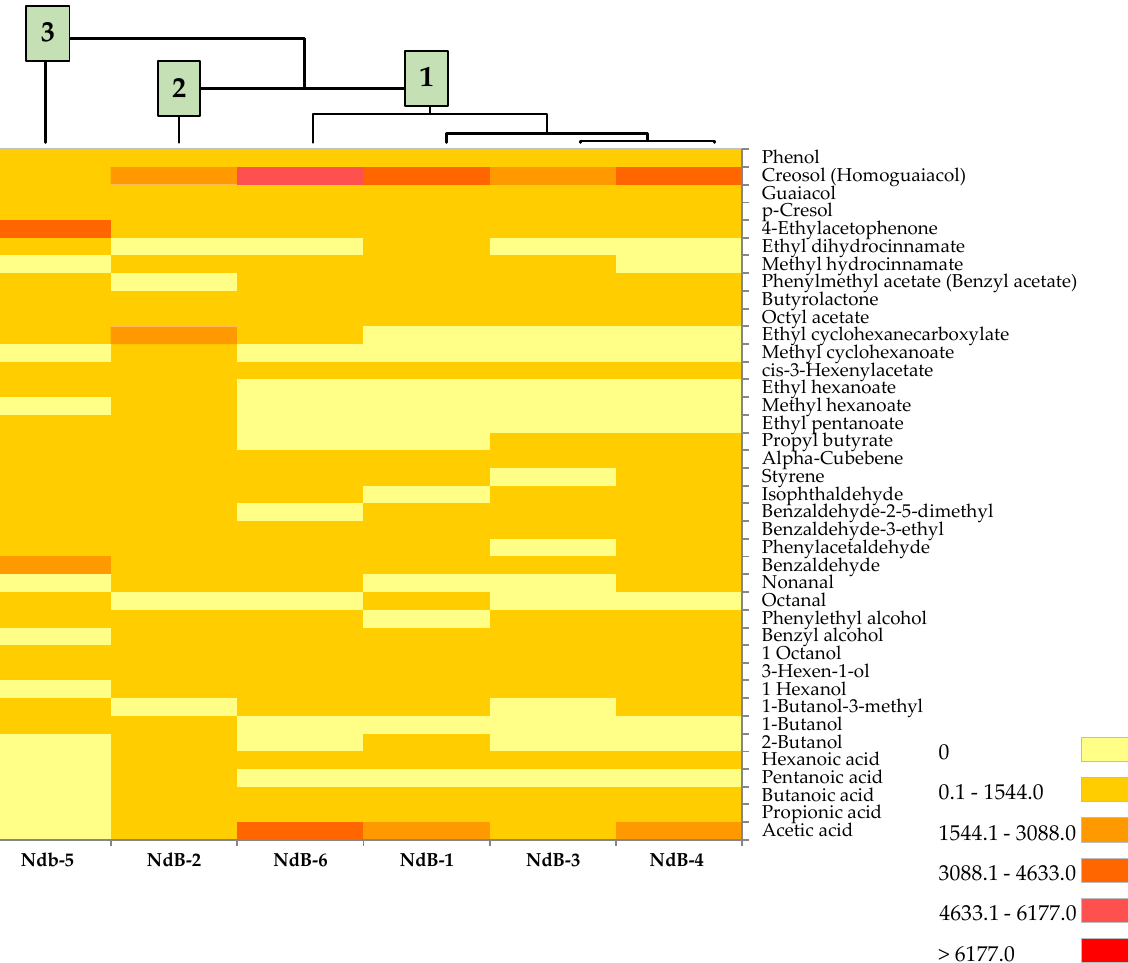
Table 4. Evaluation of the sensory a tt ributes of the experimental table olives. A tt ributes